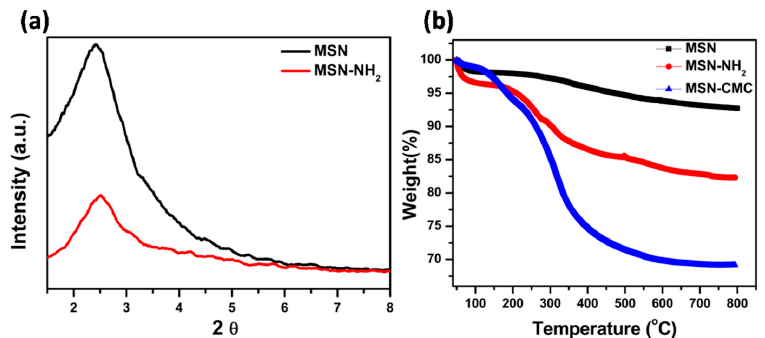
Figure 3. ( a ) X-Ray Diffraction (XRD) patterns of MSN and MSN-NH 2 and ( b ) Thermogravimetric Analysis (TGA) curves of MSN, MSN-NH 2 and MSN-CMC.